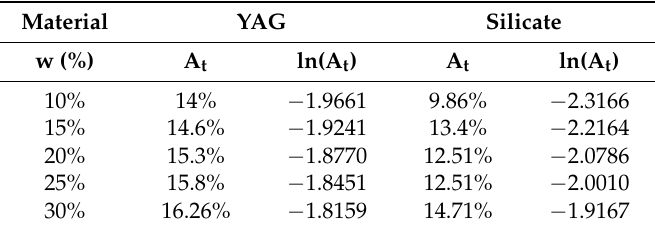
Table 2. Absorption coefficients of YAG and silicate phosphors in a real package. Material YAG Silicate w